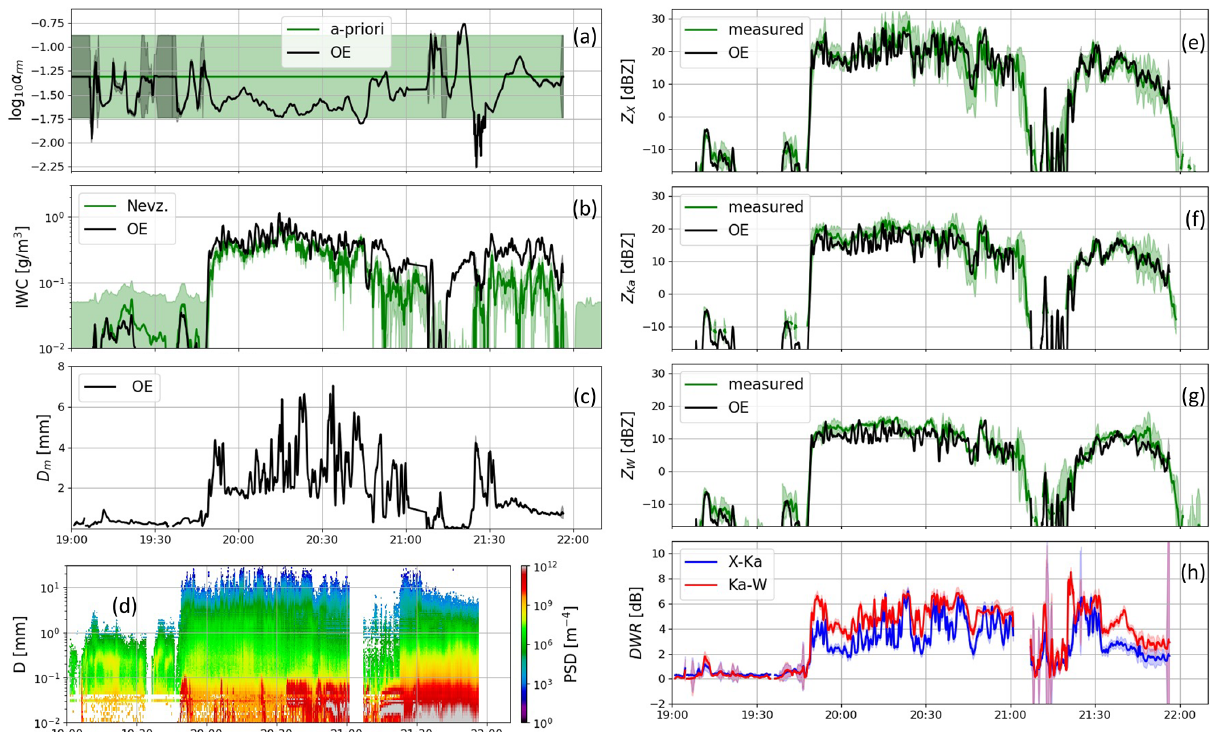
Figure 3. The estimates of the microphysical properties of snow and the radar reflectivity at the flight level. Panel (a) shows the retrieved degree of riming in black and its prior estimate in green. The retrieval is based on the data from triple-frequency radar, Nevzorov probe and PSD measurements. Panel (b) depicts the estimated IWC (black) and Nevzorov probe data (green). Panel (c) depicts the estimated mean mass-weighted diameter of snow. Panel (d) depicts the PSD data collected by the optical array probe. Panels (e–g) show the reflectivity at the X-, Ka- and W-band, respectively. The reflectivity measured above and below the aeroplane is shown as edges of the green shaded areas; the black line represents the estimated value at flight level after assimilation of radar and on-board in situ instrument data. Panel (h) depicts the optimal estimates of the DWRs. Shading in all panels represents the uncertainty in each